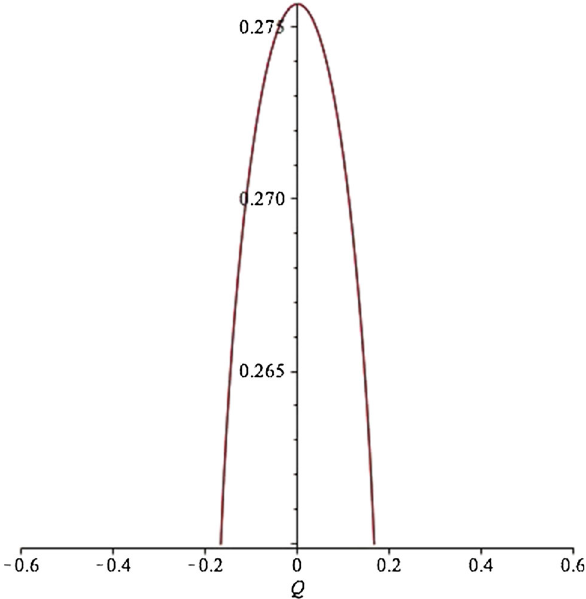
Fig. 7 T as a function of Q . This graph is confined with the condition | Q | <